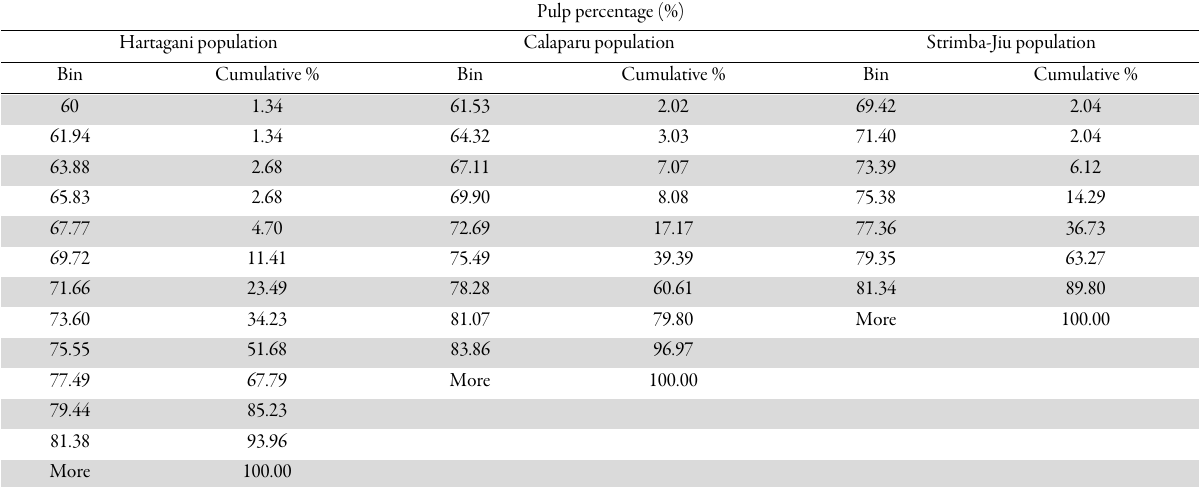
Pulp percentage (%)